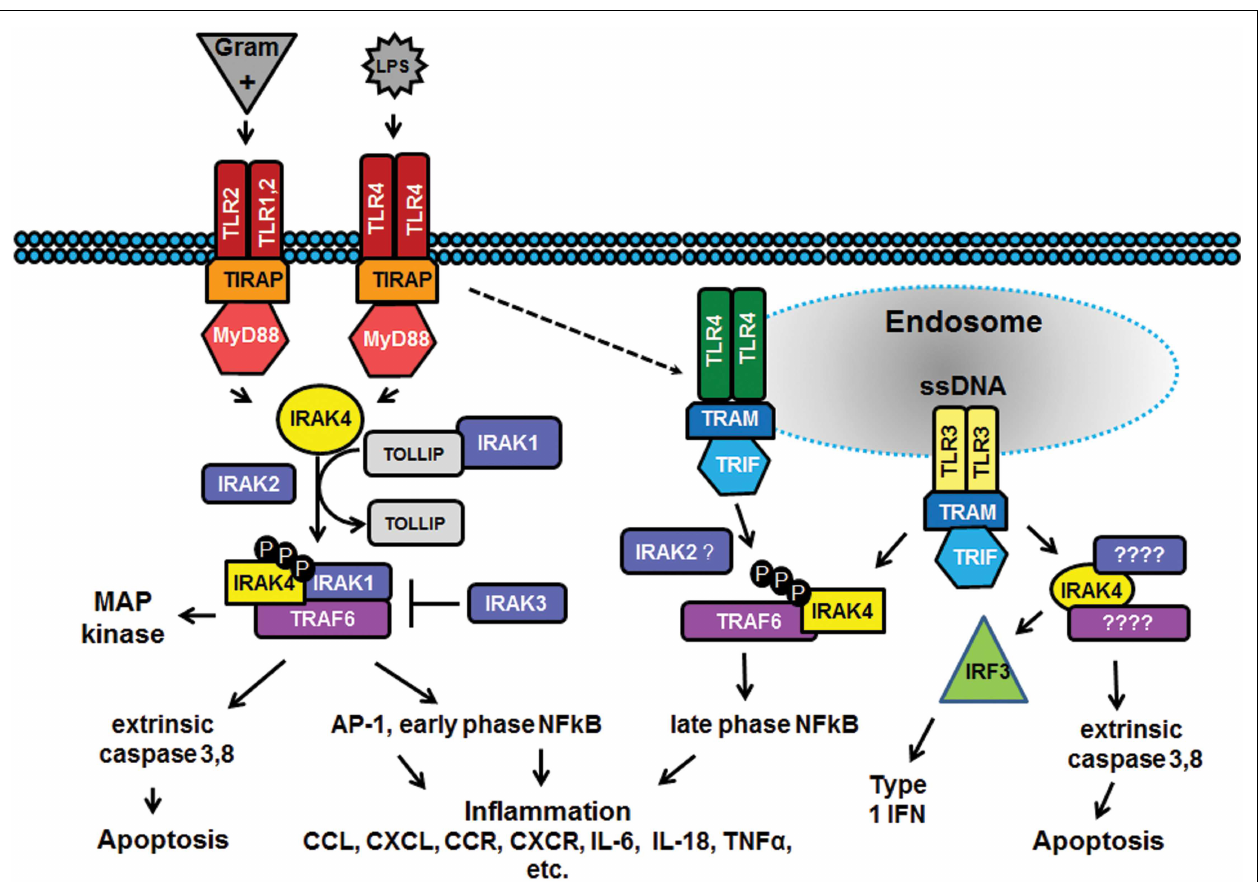
response gene 88 (MyD88, dark orange) dependent signals on the cell surface andToll-interleukin-1 receptor